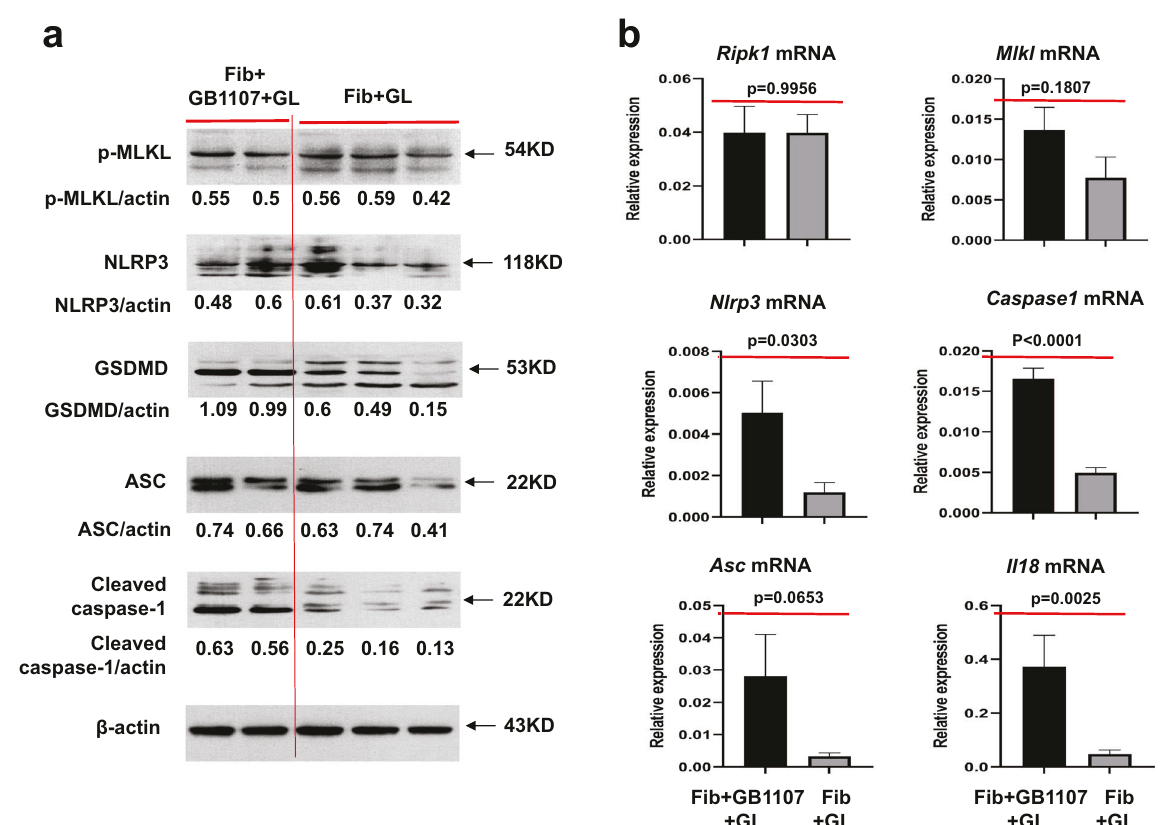
Fig. 7 GAL3 inhibition abolishes the hepatoprotection in fi brotic mice against acute insult by upregulating pyroptosis rather than necroptosis signalling. a The protein expression levels of the necroptosis signalling molecule p-MLKL and pyroptosis signalling molecules, including NLRP3, GSDMD, ASC and caspase-1, as detected by western blot in the livers of fi brotic mice upon insult with or without GB1107 treatment. b The mRNA expression levels of necroptosis signalling molecules, including Ripk1 and Mlkl , and pyroptosis signalling molecules, including Nlrp3 , Asc , Caspase1 and Il18 , in the livers of fi brotic mice upon insult with or without GB1107 treatment ( n = 5 – 8). Group comparisons were performed using Student ’ s t test or the Mann – Whitney U